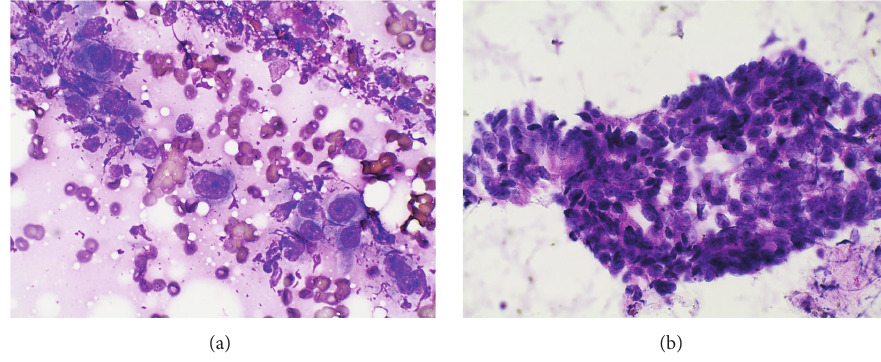
Figure 2: Imprints of the CT-guided core biopsy specimen from the left flank mass showing clusters of malignant columnar cells with a high nuclear/cytoplasmic ratio and prominent nucleoli: (a) Diff-Quik and (b) hematoxylin and eosin, ×